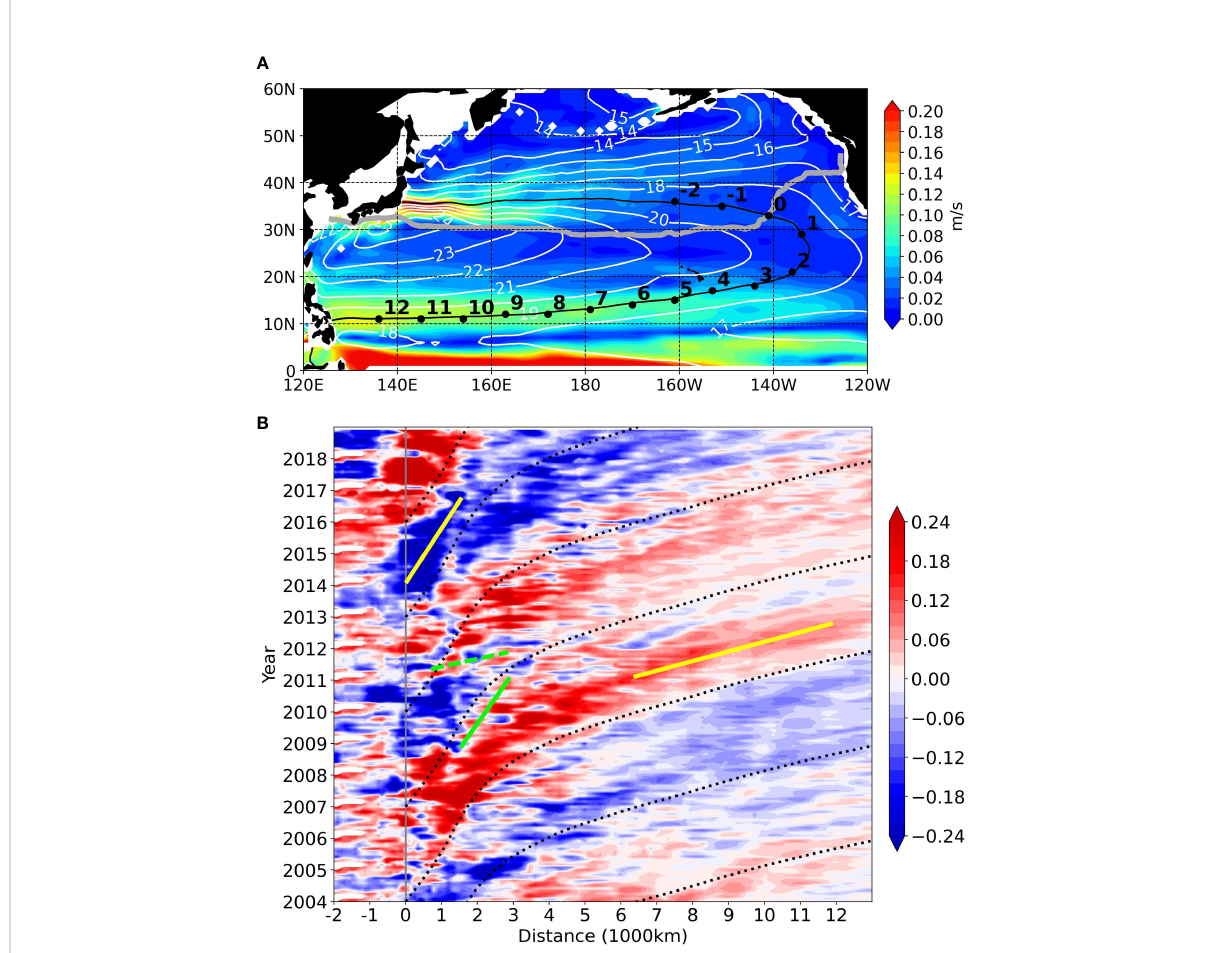
FIGURE 10 (A) Geostrophic velocity (color) and streamline (white contour) on g = 25.0 surface (unit = m/s) that was relative to 1500 dbar. Black contour denotes the 19 isopycnal stream function isopleth with positions dotted at every 1000 km distance (the great-circle distance at each pressure point) from the “ 0 ” point. The thick gray line denotes the winter outcrop line of the g = 25.0 surface. (B) Time-distance diagram of the salinity anomalies along the 19 isopycnal stream function isopleth (same as the black contour in a). The dotted black curves denote the advection by mean geostrophic velocity along the streamline, which integrated from the “ 0 ” point (gray line). The positions of every 1000 km distance are the same as the dotted points in (A) The yellow lines indicate representative propagation speeds of the anomalies, which are 0.02 m/s and 0.12 m/s respectively. The solid and dashed green lines indicate branches of the anomalies that did not propagate following the mean geostrophic speed, with speed of 0.02 m/s and 0.09 m/s